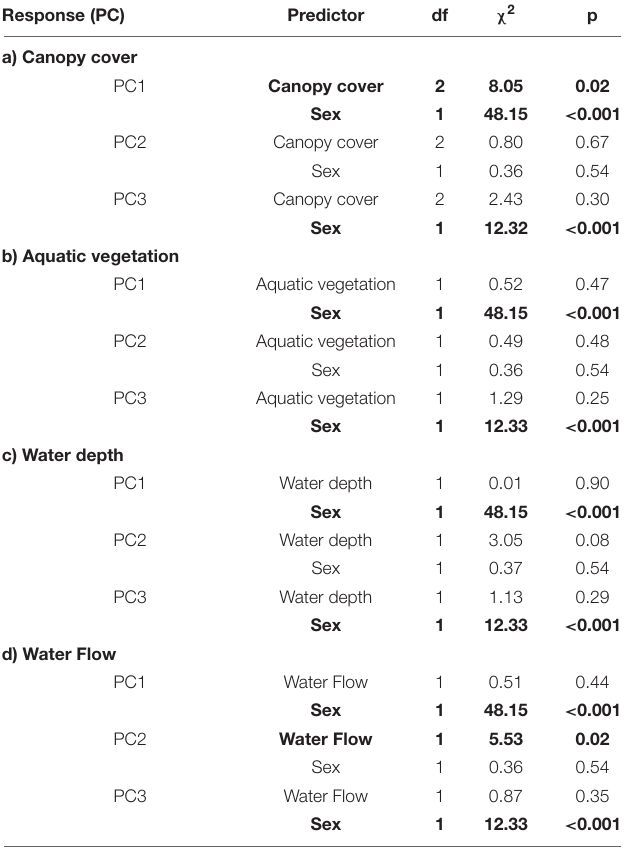
TABLE 3 | Effect of sex and environmental characteristics on PC scores representing sexual, agonistic and locomotor behaviors. Response (PC)